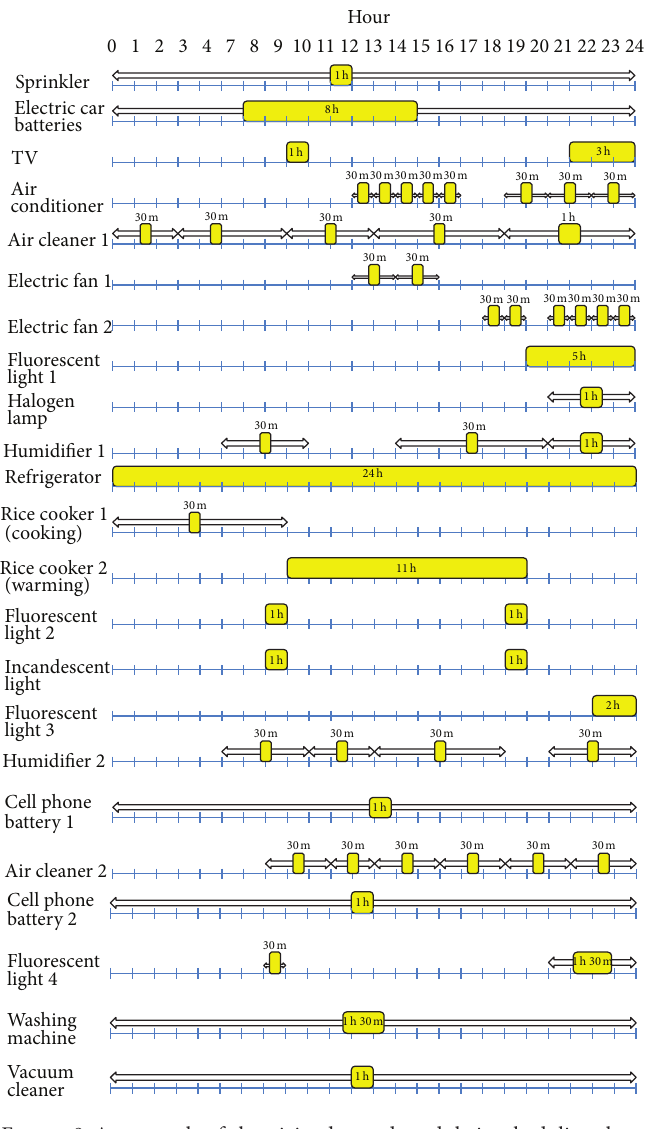
Figure 8: An example of electricity demands and their scheduling slots. Table 1: Electricity Prices used in the experiments